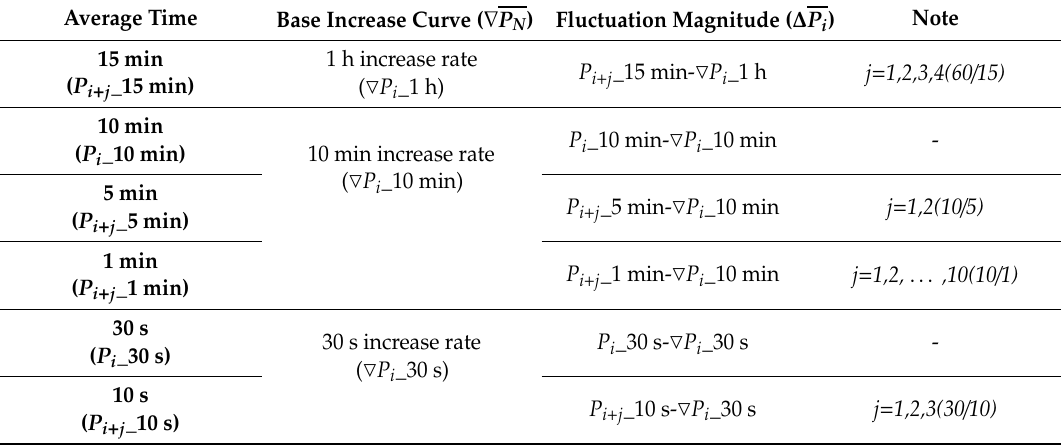
Table 4. Calculation of the load fluctuation magnitude about MA.